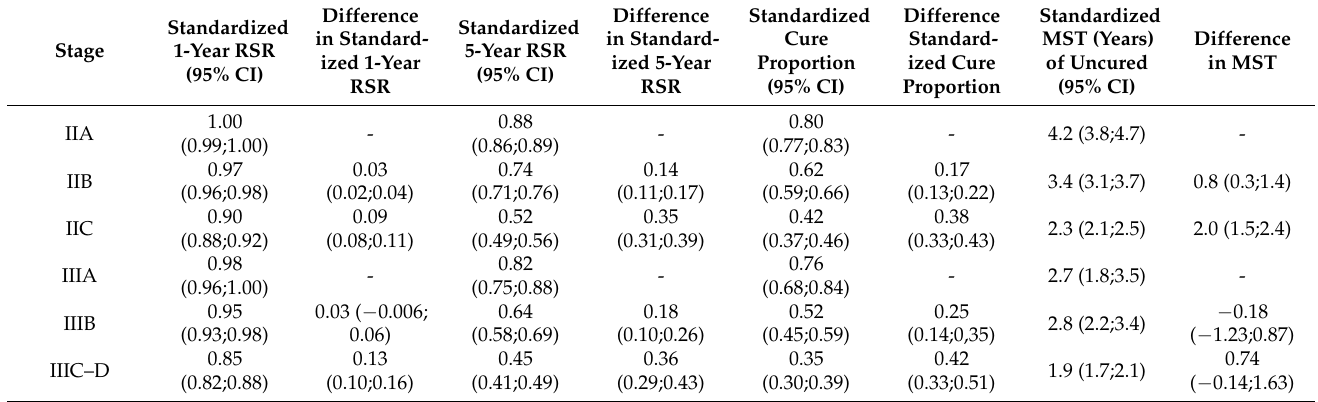
Table 2. Standardized 1-year relative survival ratios (RSR), 5-year RSR, cure proportions and median survival times (MST) of